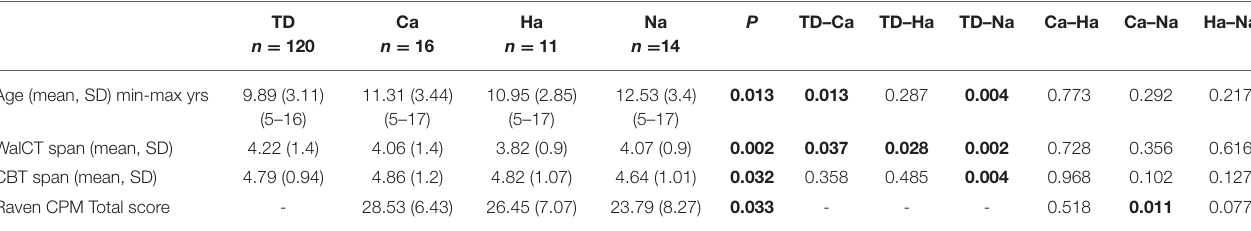
TABLE 2 | Age and spans of walking Corsi test (WalCT) and Corsi block test (CBT) and Raven’s CPM total in groups of typically developing children (TD) and children in various ambulation